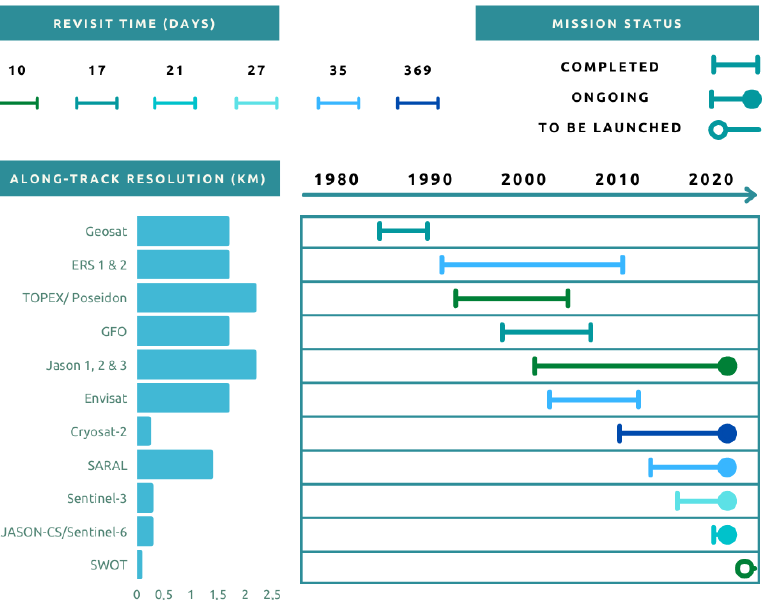
Figure 1. Satellite altimetry missions compatible with teroVIR and teroWAT processors, from first available operational data (GeoSat, starting 1986) until present and future